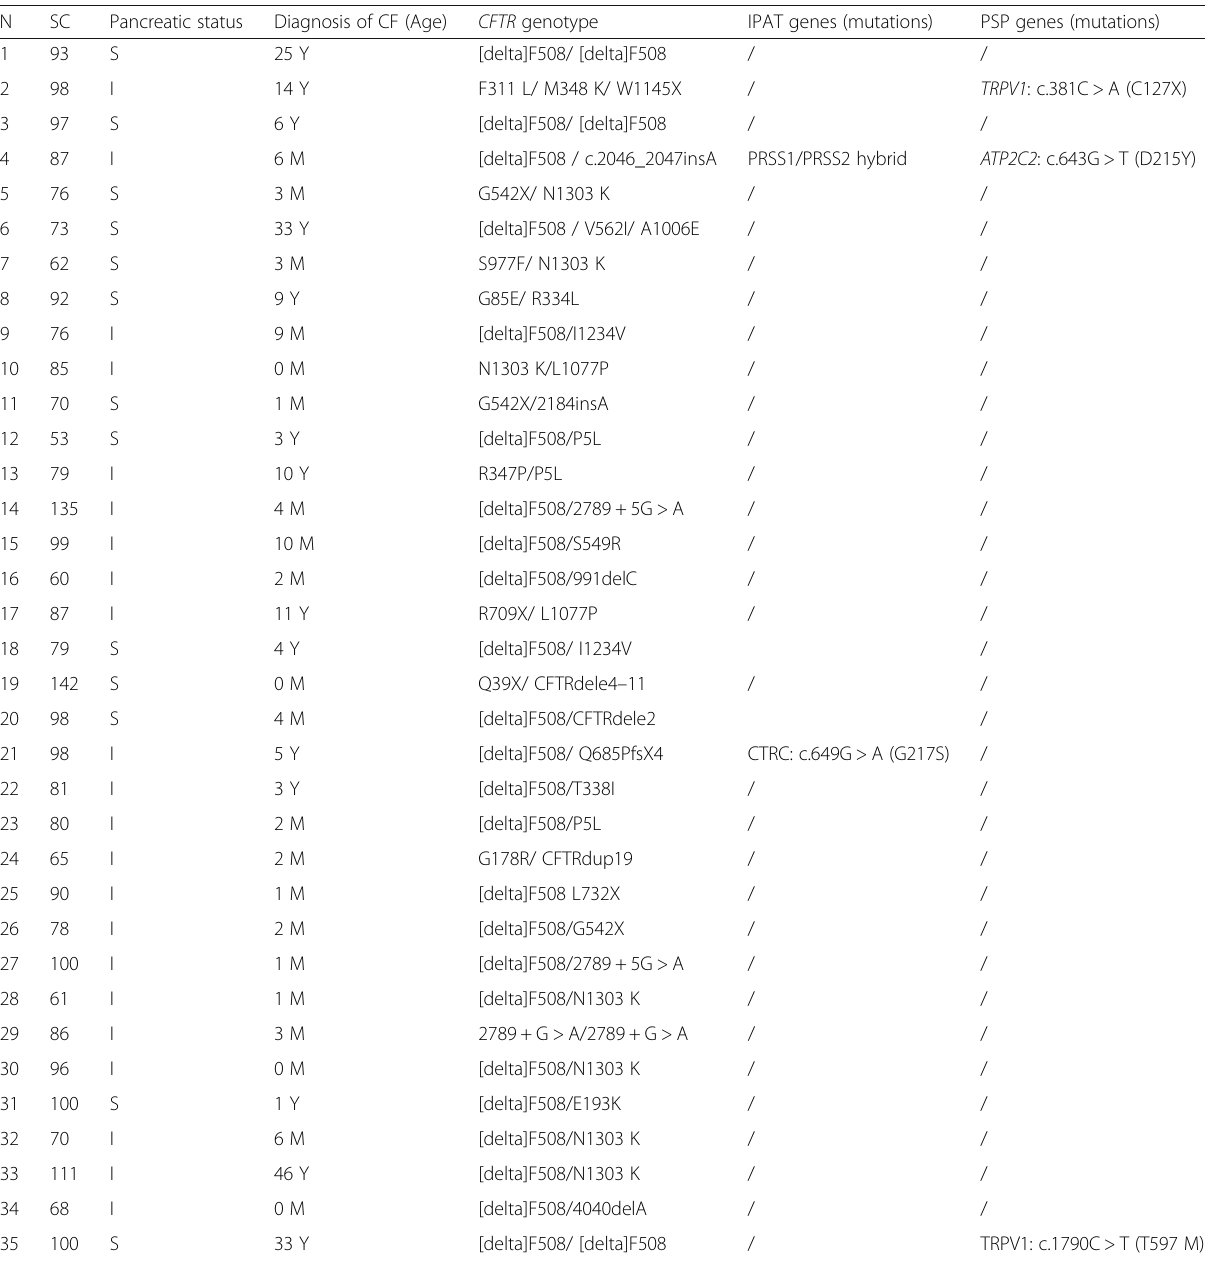
Table 3 Sweat chloride (mmol/L, SC), genotype of CFTR, intra-pancreatic activation of trypsin (IPAT) and pancreatic secretion pathway (PSP) genes in patients with CF without chronic